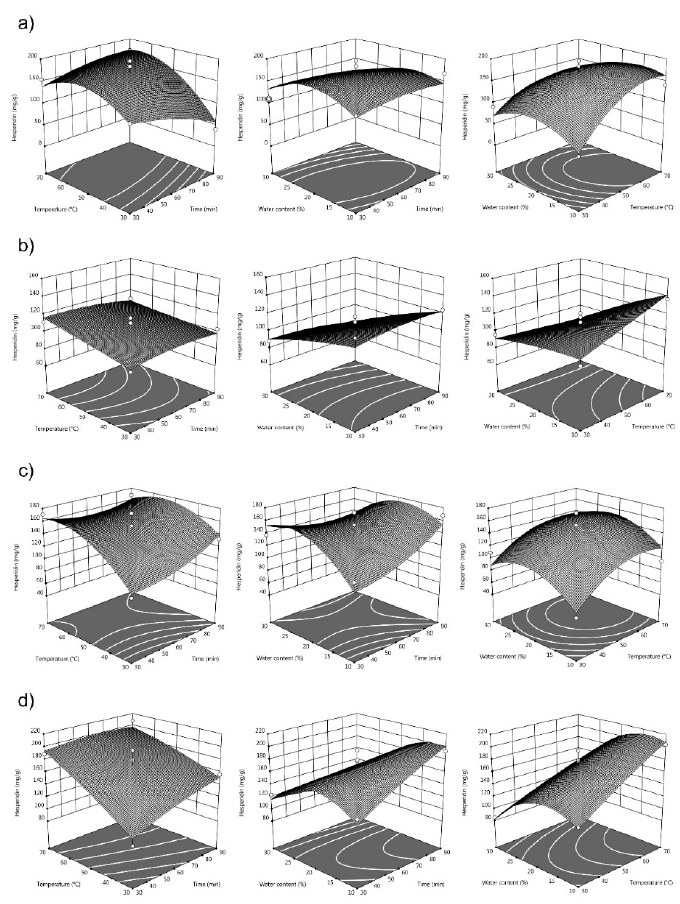
Figure 3. Response surface plots showing the e ff ects of temperature, extraction time and water content on the extraction yield of hesperidin in di ff erent mandarin varieties: ( a ) Okitsu ; ( b ) Chahara ; ( c ) Kuno ; ( d ) Zorica Rana .